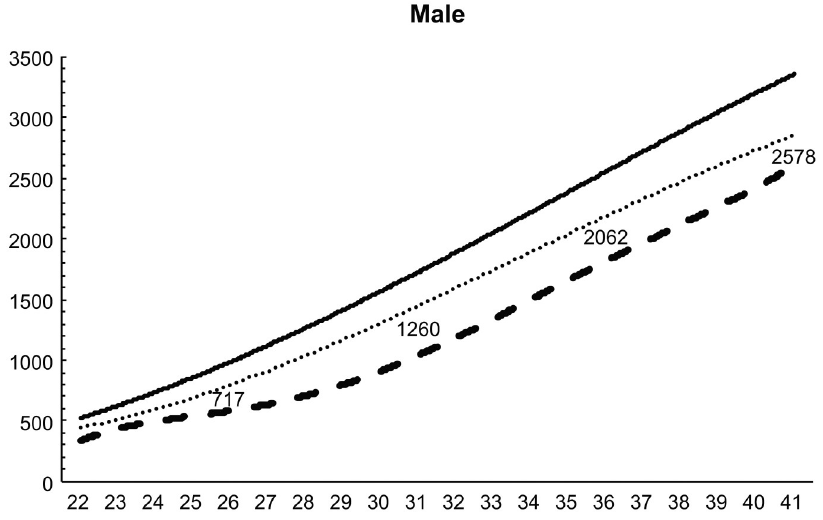
Fig 2. Birth weight reference curves for each week (male, primiparous).